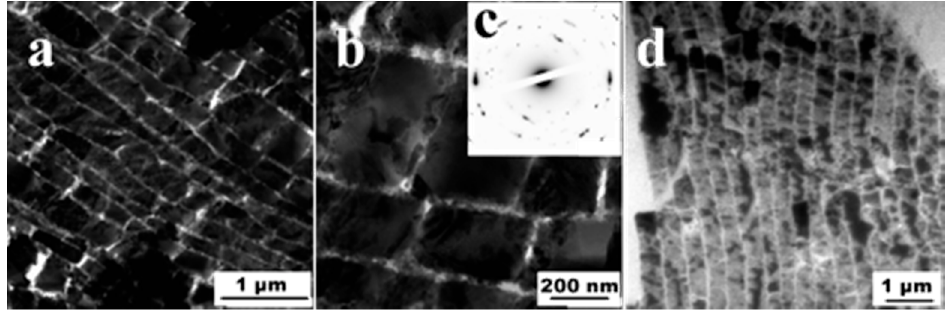
Figure 5. Using an insoluble organic nacre matrix as the template to retro-synthesize nacre layers. TEM micrographs of ( a , b ) of highly mineralized parts of synthetic nacre after 24 h reaction time. ( c ) Electron diffraction pattern of the platelets in panel b. ( d ) Original nacre from Haliotis laevigata . Reproduced with permission from the American Chemical Society in Reference [109].